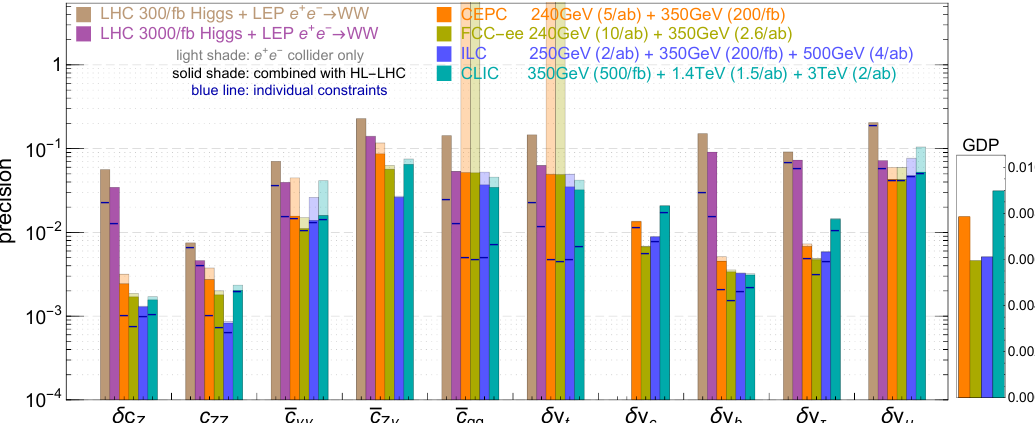
Figure 13 . Same as (cid:12)gure 7 but assuming vanishing aTGCs. Imposing (cid:14)g both (cid:21) Z and c are eliminated, while the relation e 2 c (cid:13)(cid:13) + ( g 2 Z (cid:3) imposed among c ZZ , c (cid:13)(cid:13) and c Z(cid:13) . Note that the individual constraints are basis dependent. We use the above relation to eliminate c Z(cid:13) , hence its individual constraints are not shown.